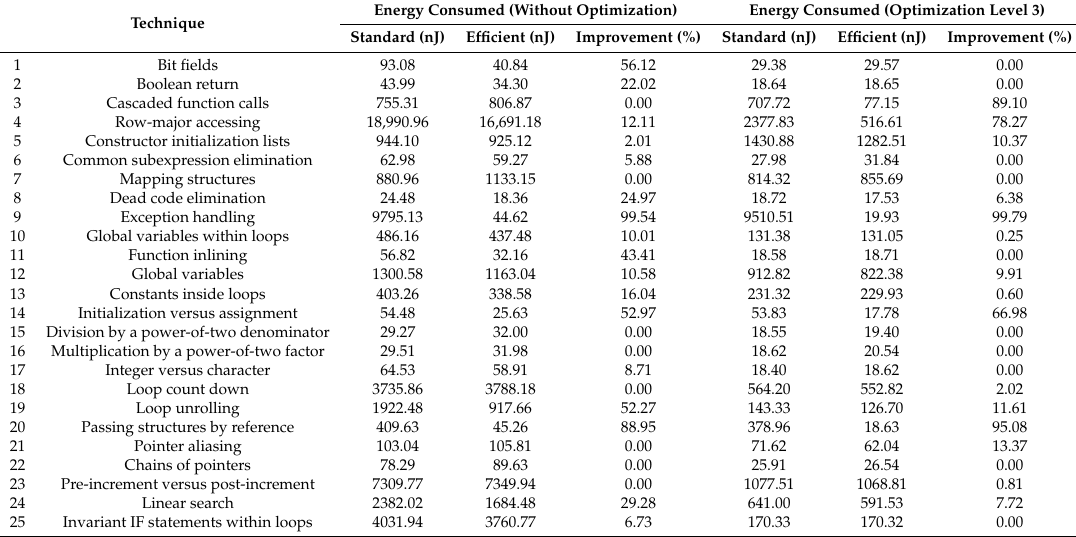
Table 5. Energy results and percentages of improvement in Raspberry Pi